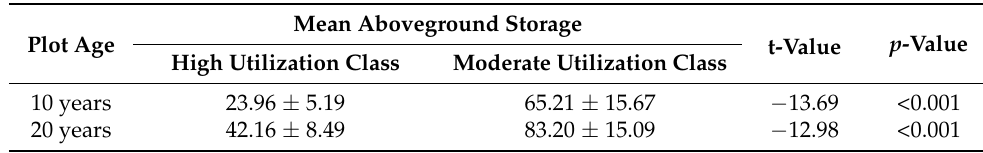
Table 3. Comparisons of aboveground carbon storage between sites at different age classes of abandoned fallows.